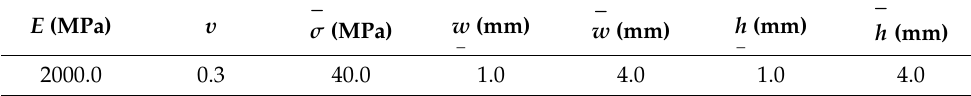
Table 1. Material properties and stiffener limiting dimensions.